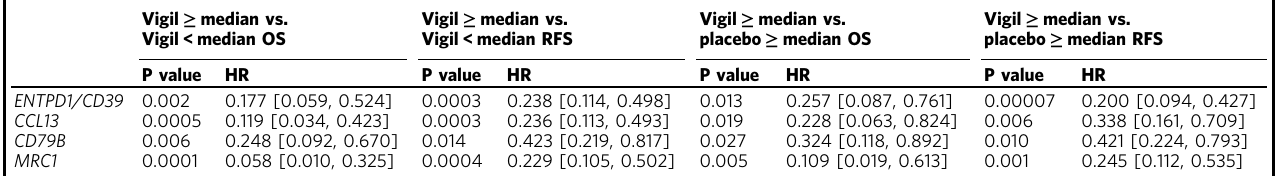
Table 3 One-sided p values of log-rank test comparing two KMs and hazard ratios and 90% CI from the univariate Cox proportional hazards model based on four predicted genes from multivariate